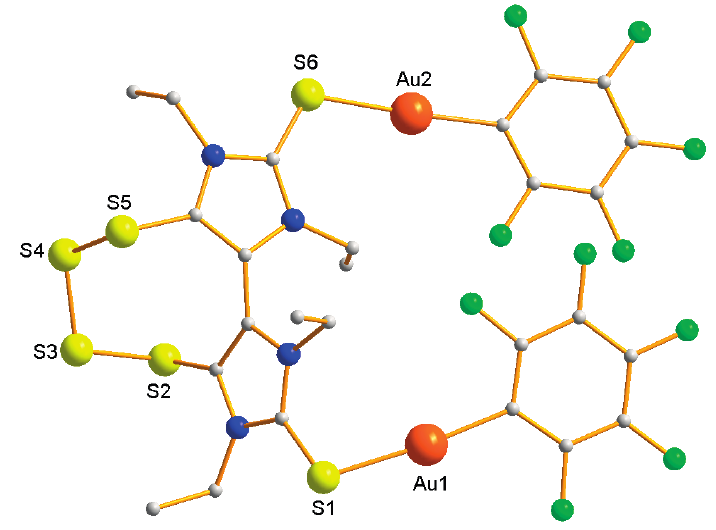
Figure 1. Molecular structure of the compound 1 , with the atom labeling scheme (hydrogen atoms omitted for clarity).